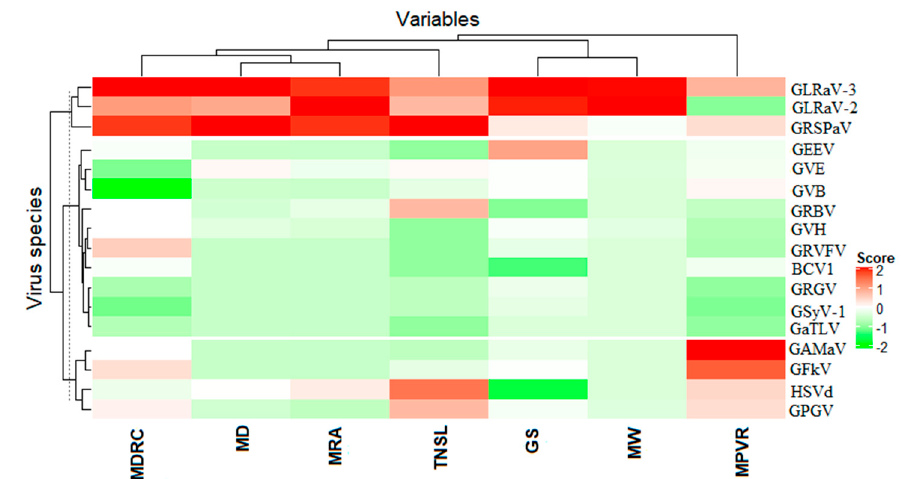
Figure 4. Heatmap displaying the characteristics and association between detected viruses and the mean proportion of viral reads that mapped for a given virus (MPVR), total number of symptomatic leaves (TNSL) associated with a given virus, mean depth (MD), mean depth relative to the depth of the positive control virus (MDRC), mean relative abundance (MRA), mean weight and genome size (GS). The pam function of the cluster package was used for partitioning the data into k cluster around Medoids (k-Medoids, (k = 3)) because it is less sensitive to outliers compared to k-means [33]. R packages ComplexHeatmap, circlize, colorspace, dendextend, cluster and GetoptLong were used (see materials and methods section for more details). For virus names and abbreviations, please see Table 1.